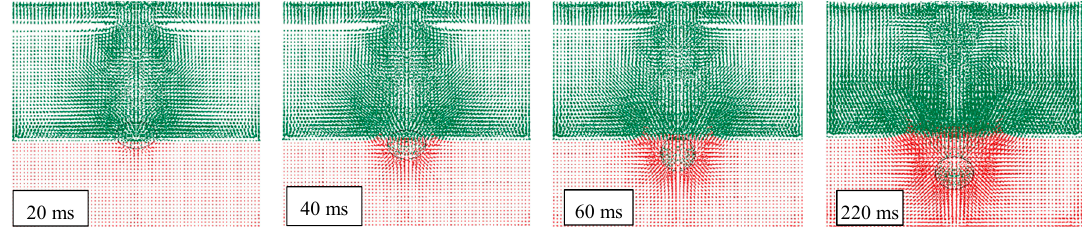
Figure 4. FEM-SPH model used for simulating the water penetration (drop height of 1500 mm).